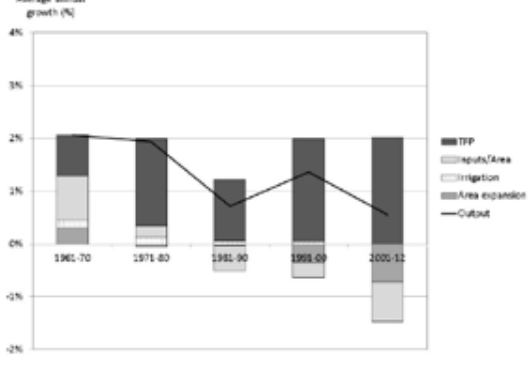
Figure 3. Sources of Agricultural Growth in Industrialized, Developing, and Transition Economies.